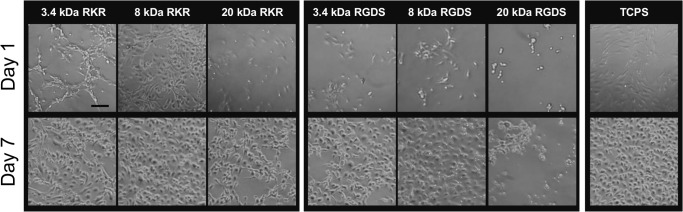
VECs adhere onto hydrogel scaffolds immobilized with extracellular matrix-derived peptides.Representative images of valve endothelial cell (VEC) adhesion and growth when seeded on combinations of 3.4, 8, or 20 kDa molecular weight PEGDA hydrogels with immobilized CRKRLQVQLSIRT (RKR) (first panel) or CRGDS (RGDS) (second panel) and on tissue culture treated polystyrene (TCPS) on days 1 and 7. Scale bar = 100 μm.